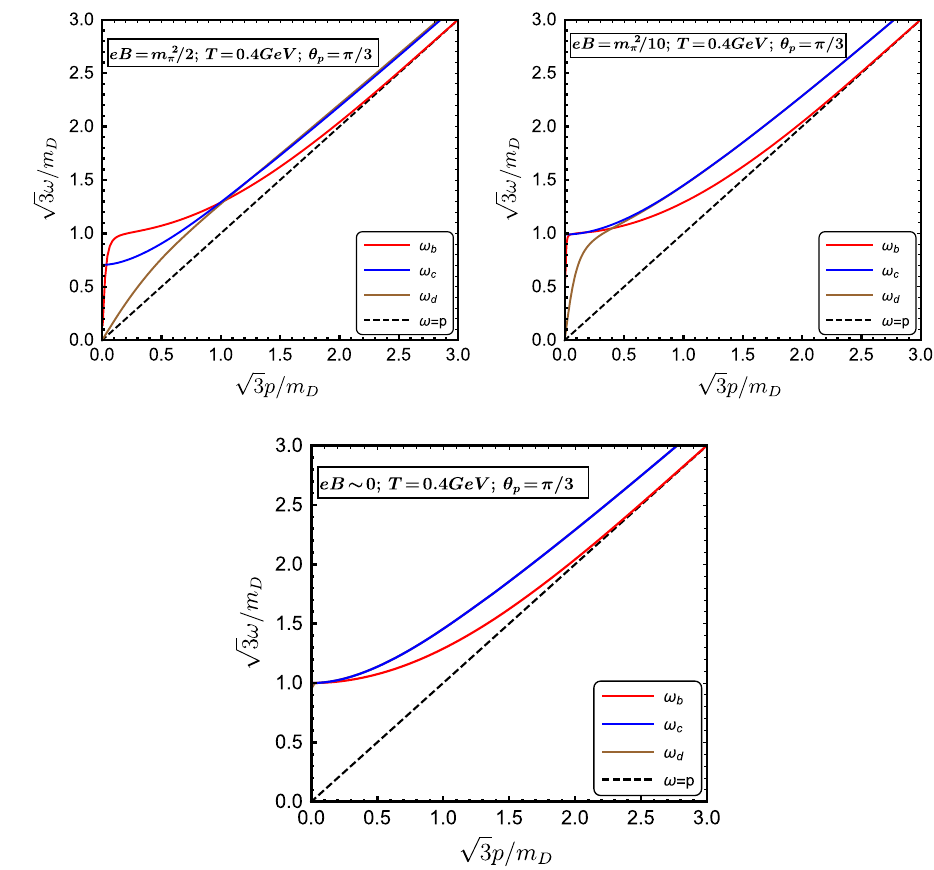
Fig. 6 Gluon dispersion curves for θ p = π/ 3 but with varying magnetic field strength eB = m 2 π / 2 , m 2 π / 10 and m 2 π / 800 ( ∼ 0 ) for N f =